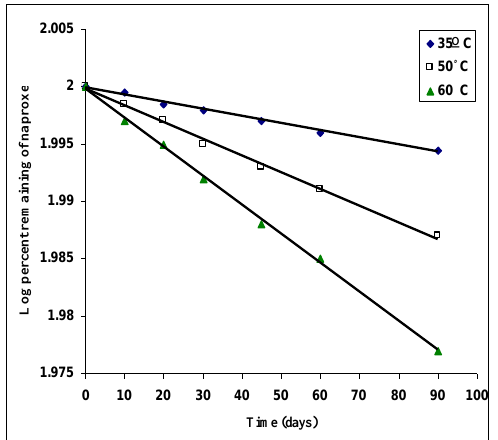
Figure (8): Accelerated stability study of naproxen in the selected formula at elevated temperatures (35, 50 and 60 ºC).